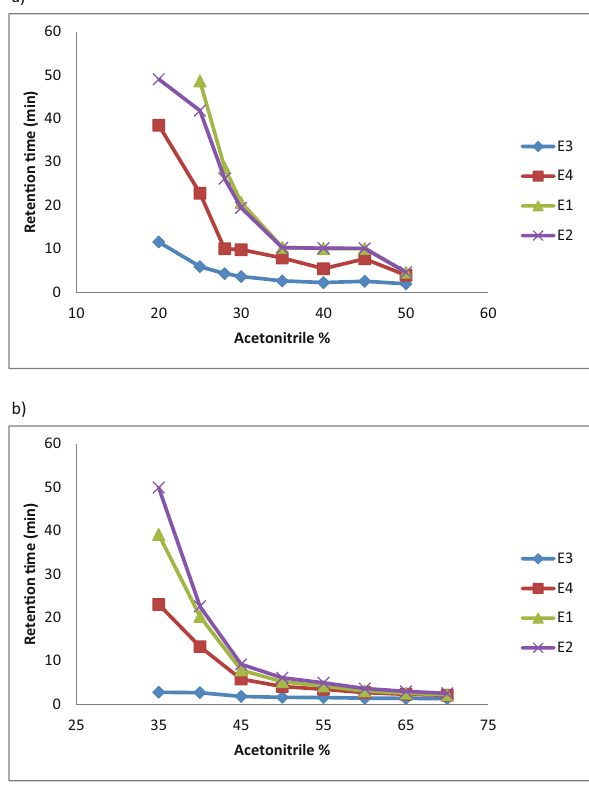
Figure 1: The e ff ect of acetonitrile % on the retention time of the studied estrogens using C 18 column, 10 µm ( 3.9 mm × 150 mm ) ( a ) and C18 column, 3.5 µm ( 4.6 mm × 150 mm ) ( b )